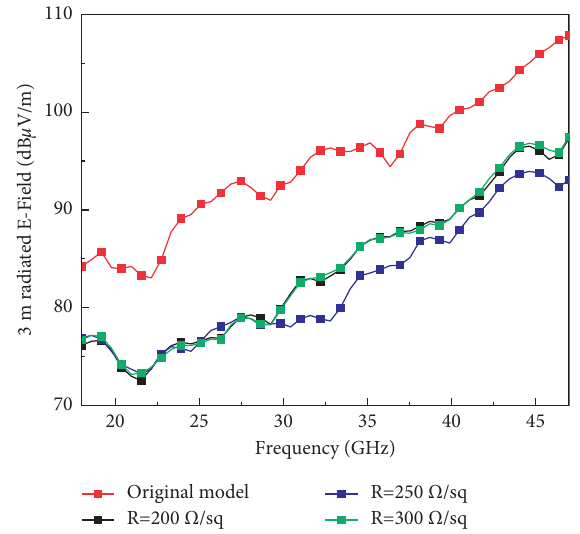
Figure 27: Radiated E-Field under different square